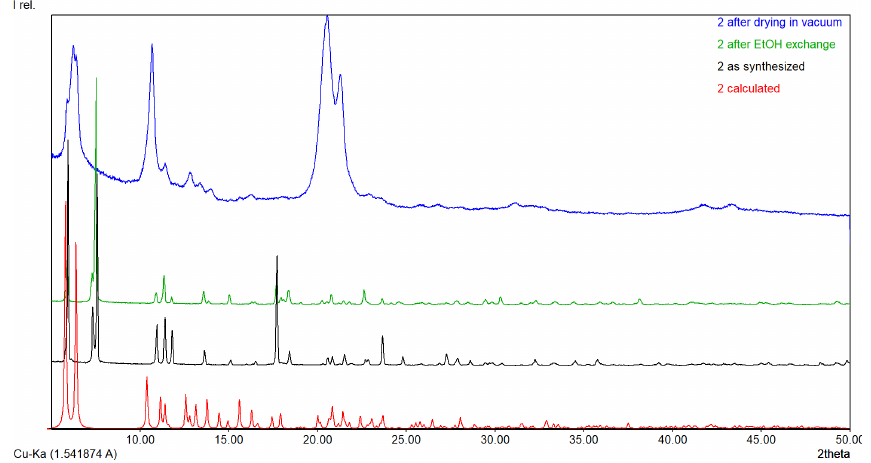
Figure 6. Diffractograms corresponding to compound 2 calculated from the cif file (red), as syn- thesized (black), after exchange with EtOH (green), and after drying in vacuum (blue).